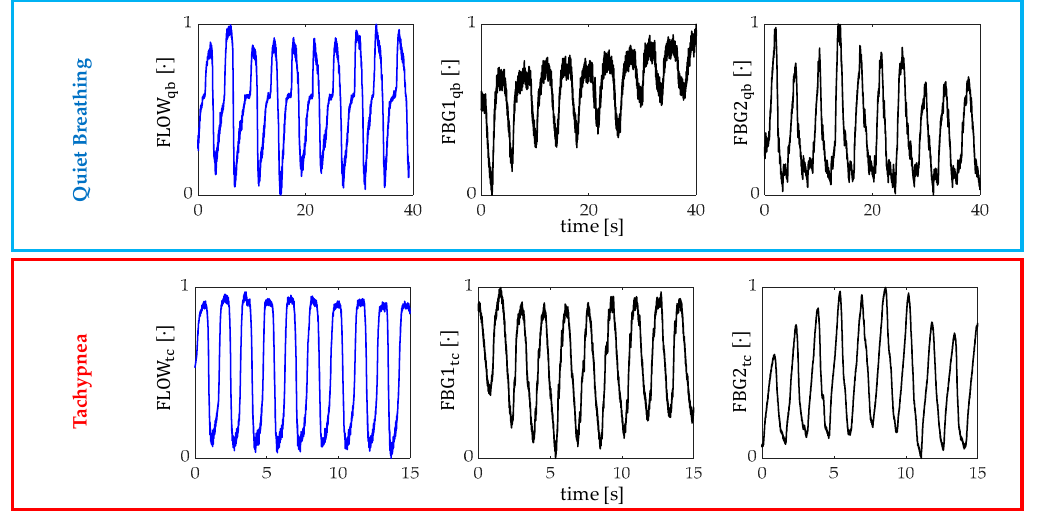
Figure 6. Signals collected by the flowmeter (blue trend) and by the FBGs (black trend) during both quiet breathing (light blue box) and tachypnea (red box).